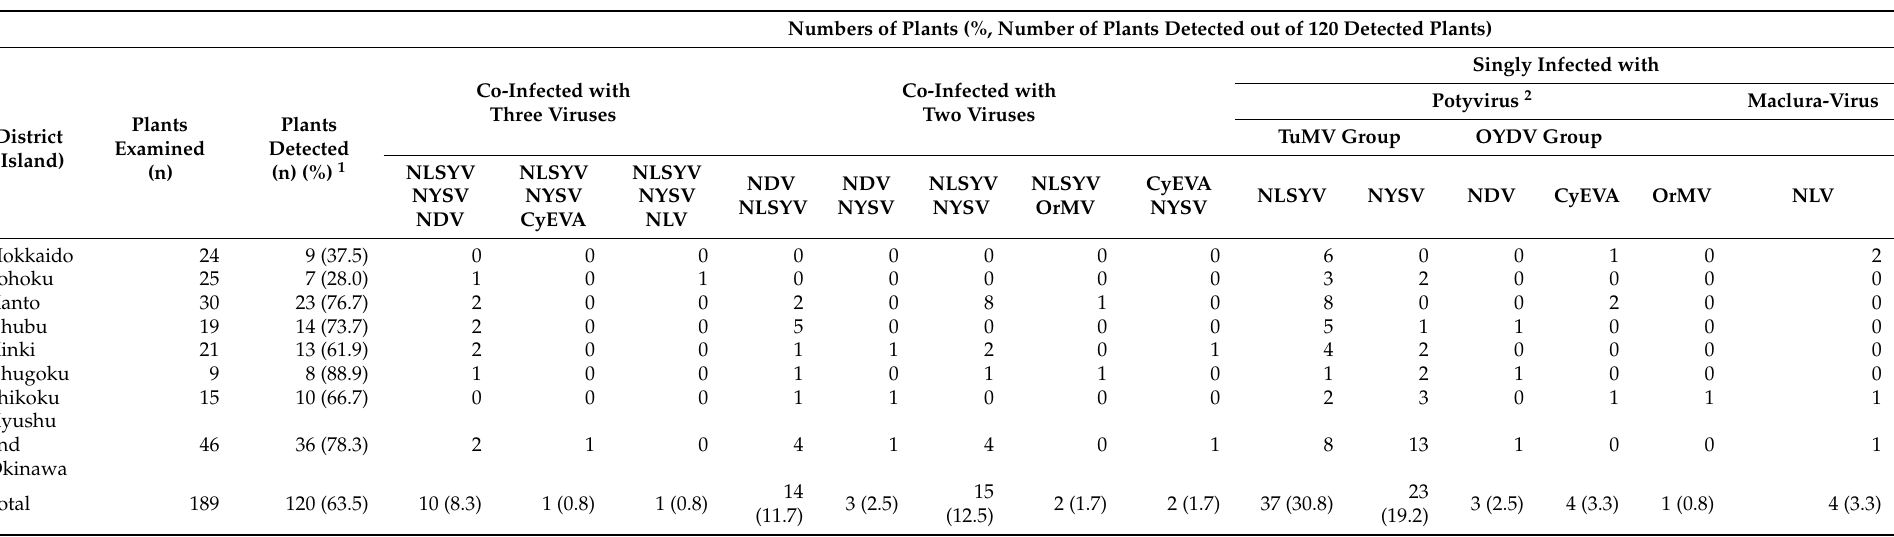
Table 1. Detection of viruses in the family Potyviridae , including narcissus degeneration virus and narcissus late season yellows virus, in Japan. Numbers of Plants (%, Number of Plants Detected out of 120 Detected